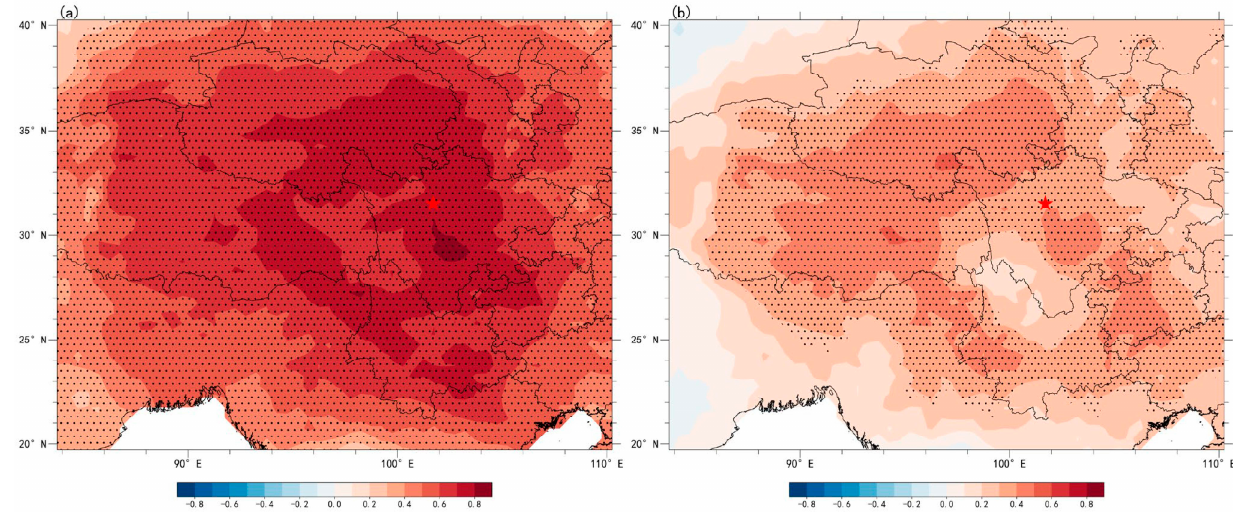
Figure 7. Spatial correlations of observed ( a ) and reconstructed ( b ) Tmin JJ with CRU data during the period of 1962~2010. The do tt ed area indicates 95% con fi dence.